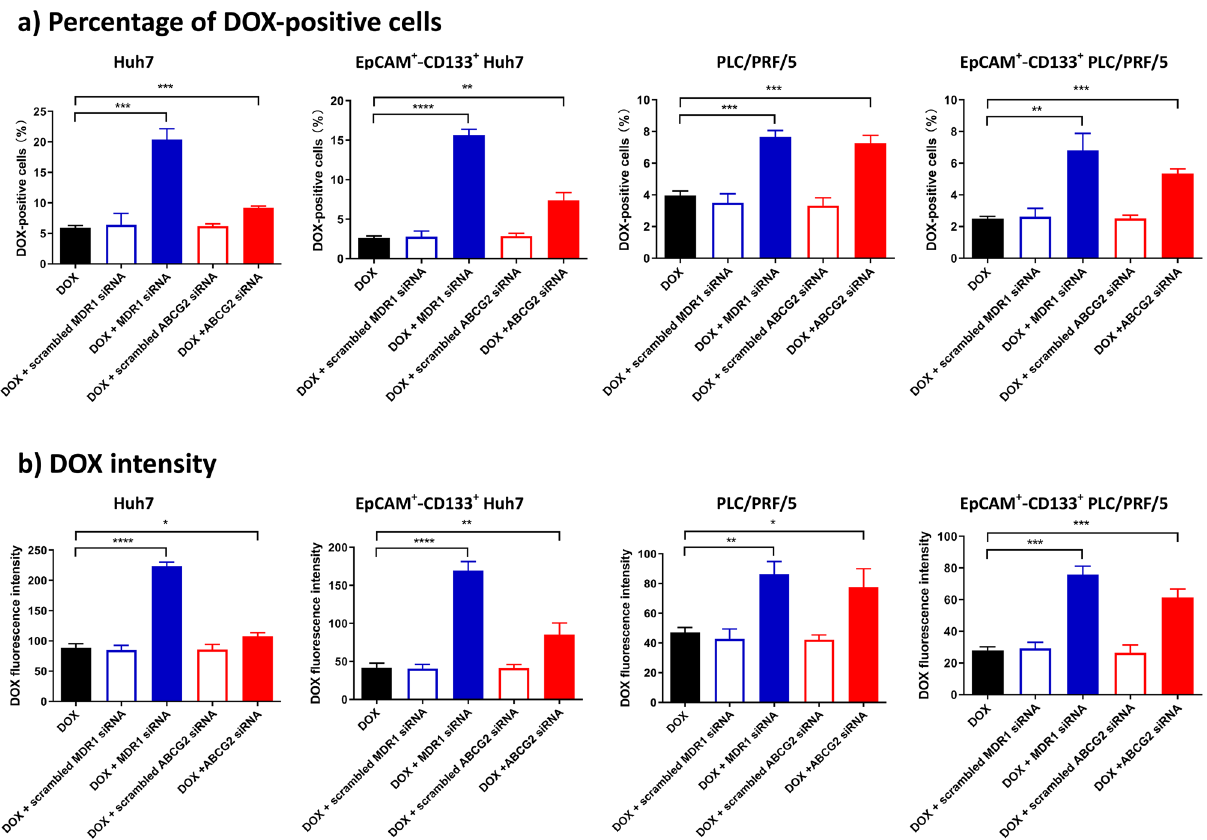
Figure 4. The downregulation of ABCG2 or MDR1 via RNAi and the intracellular concentration of doxorubicin (DOX). Cells were treated with siRNAs (20 nM) against MDR1 or ABCG2 for 6 h followed by a further 42 h culture in the fresh culture medium. Then the Huh7 cells or PLC/PRF/5 cells were treated with 200 nM or 100 nM of DOX for 24 h. The intracellular retention of DOX measured as ( a ) the percentage of DOX- positive cells or ( b ) their intracellular DOX fluorescence intensity was determined via flow cytometry in the bulk Huh7 and PLC/PRF/5 cells as well as in their EpCAM + –CD133 + counterparts. Data shown are means ±